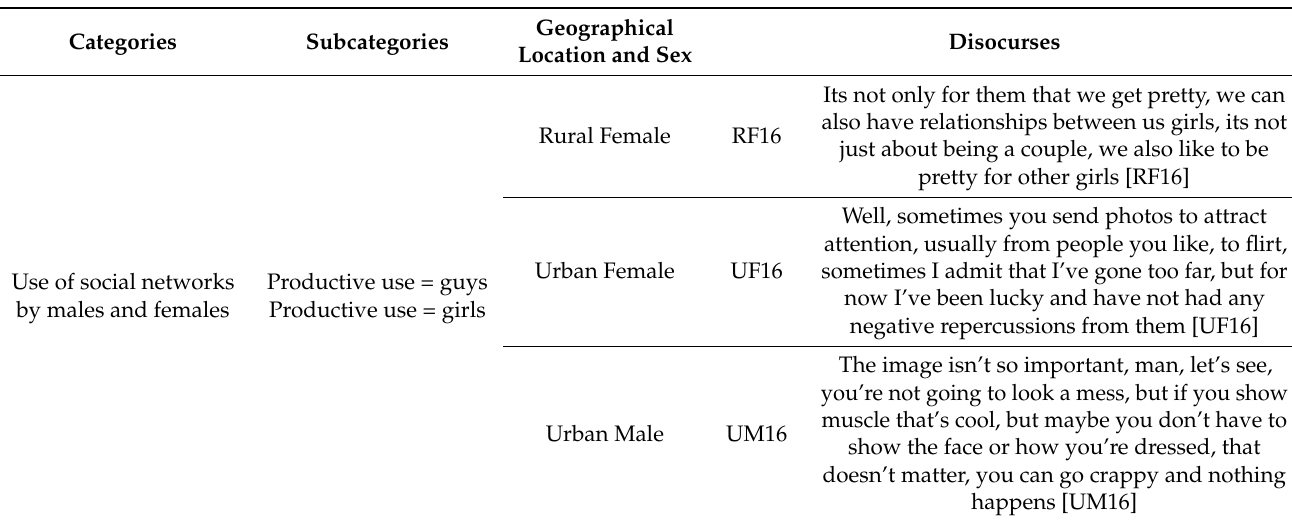
Table 9. Difference between the sexes in the degree of intimacy shown by the photographs displayed on social